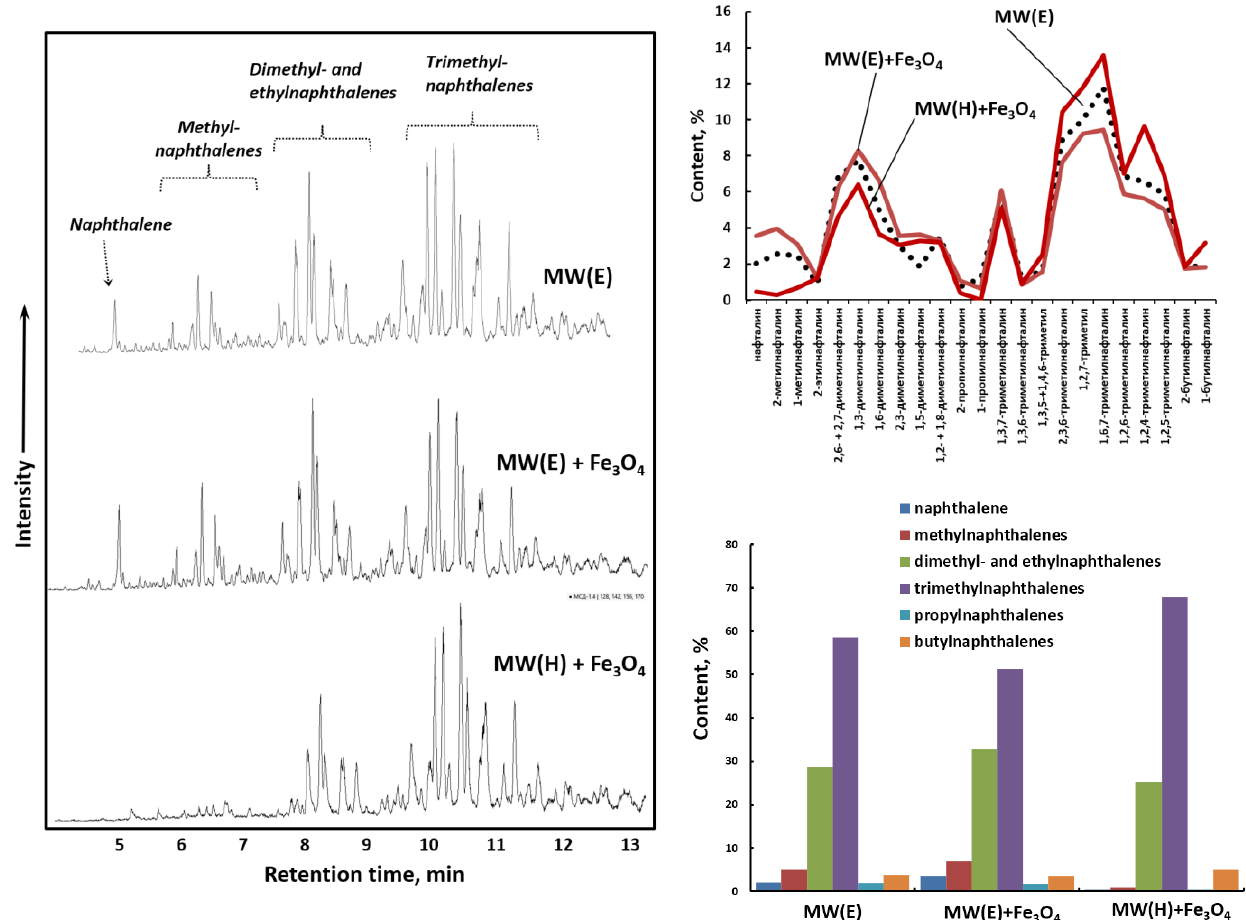
Figure 6. Chromatograms and relative contents of naphthalene and its homologues in the aromatic fraction of the studied oil samples after exposure to microwave radiations. In the lower-right corner—changes in the content of naphthalene and its homologues.